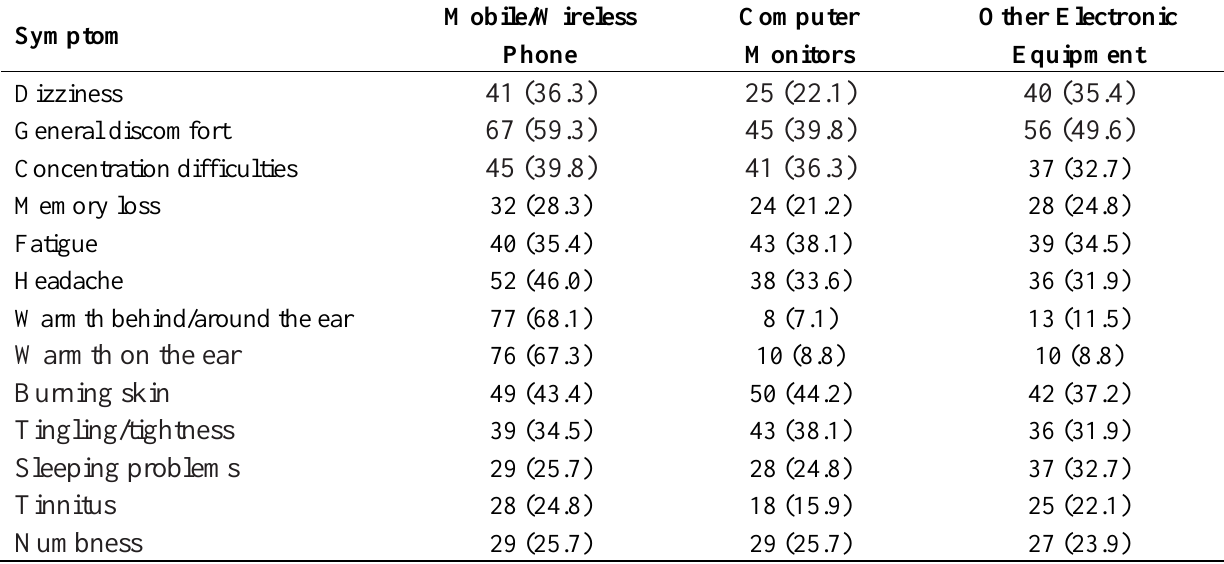
Table 1. Number of participants (%) in the group with electromagnetic hypersensitivity who reported specific symptoms attributed to different sources.